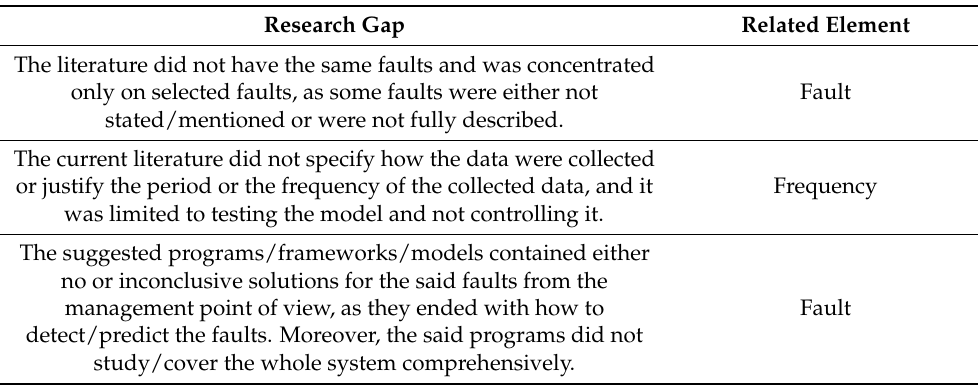
Table 1. SLR’s research gaps.